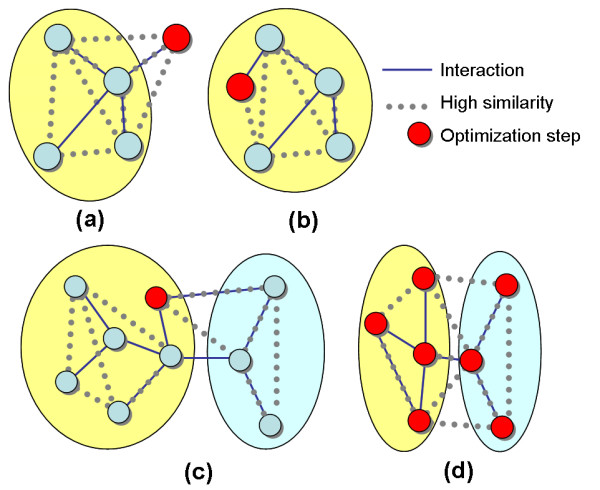
Toy examples of the moves performed by the optimization algorithm. (a) Node addition; (b) Node removal; (c) Assignment change; (d) JACS merge. In each case the affected nodes are in red (black).